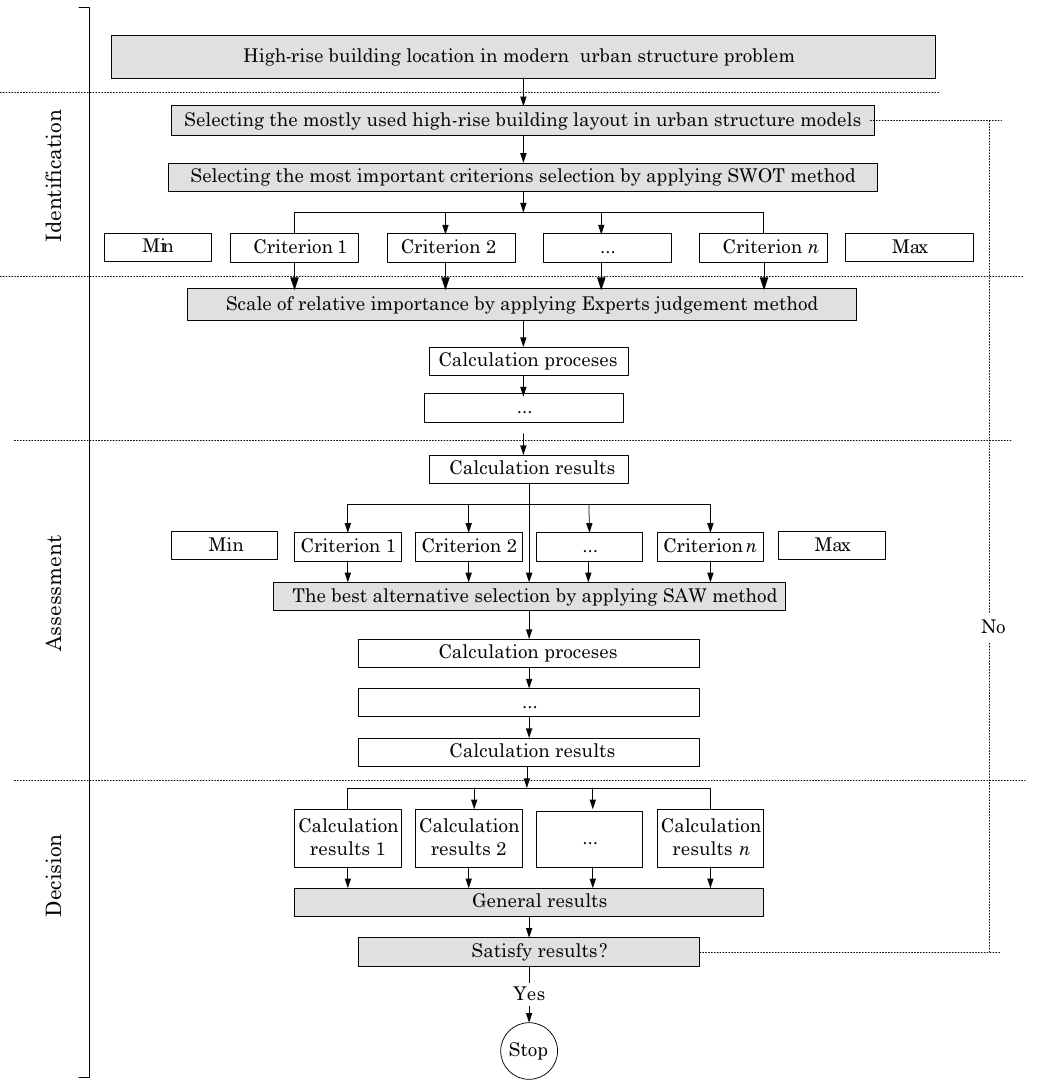
figure 2. The complex assessment model with SWOT, expert judgement and SAW